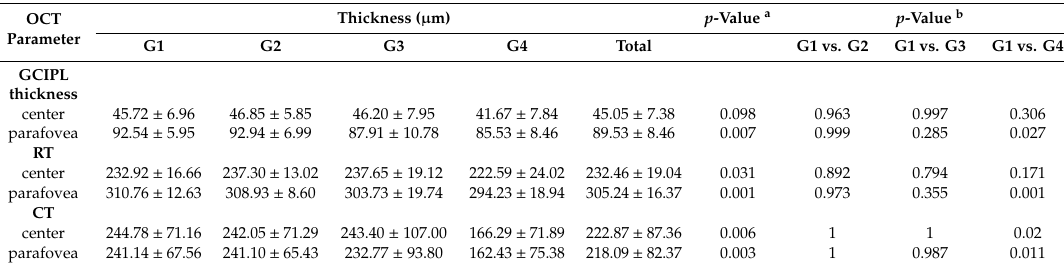
Table 4. Retinal and choroidal thickness by age group.